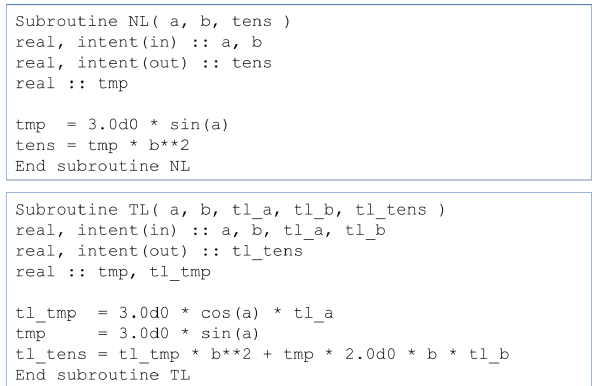
Figure 2. Example of the tangent linear subroutine called TL based on the nonlinear subroutine called NL. The subroutines displays input and output with capital letters I and O in the argument variables.